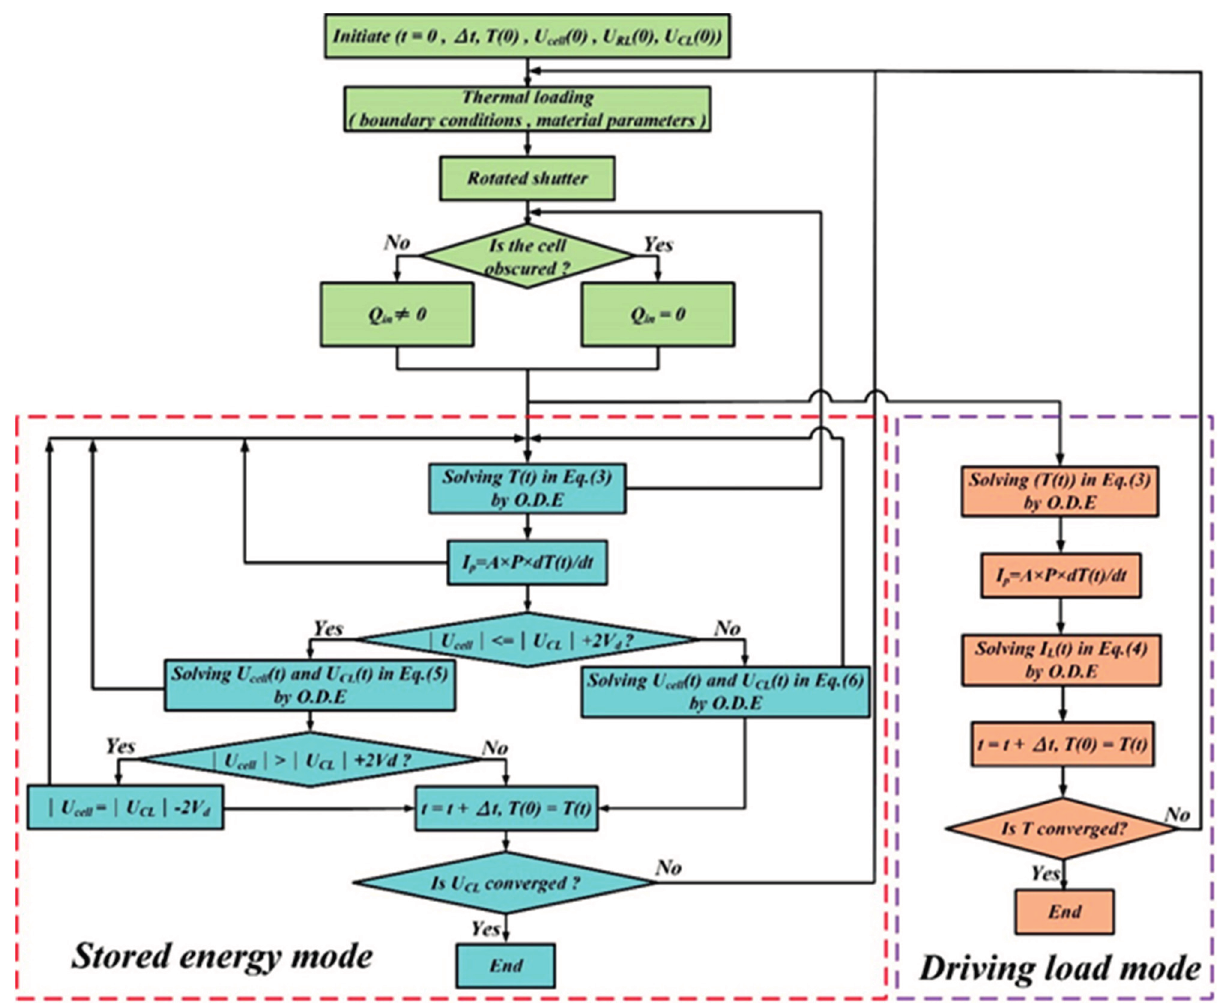
Figure 5. Theoretical analysis for integrating the thermodynamic and the electric models of pyroelectric